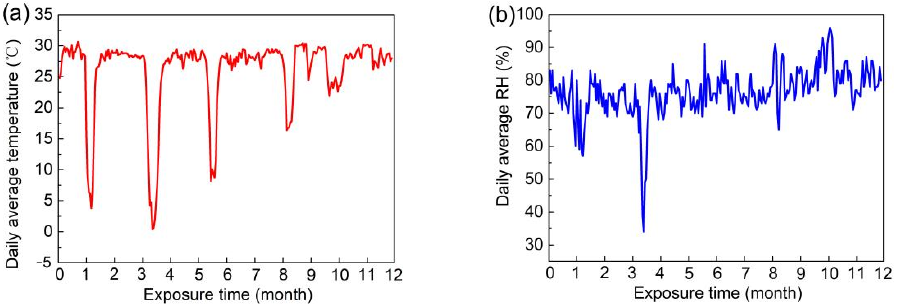
Figure 2. Daily average temperature and relative humidity at exposure test site during voyage: ( a ) temperature, ( b ) relative humidity.